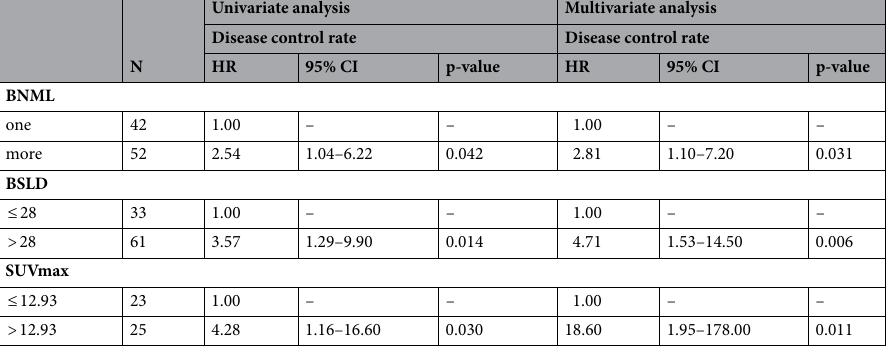
Table 3. The association between the tumor burden and the response to anti-PD-1 monotherapy in patients with recurrent or metastatic head and neck cancer. Adjusted by age, sex, Eastern Cooperative Oncology Group performance status. HR hazard ratio, CI confidence interval, BNML the baseline number of metastatic lesions, BSLD the baseline sum of the longest diameters of the target lesions, SUV standardized uptake